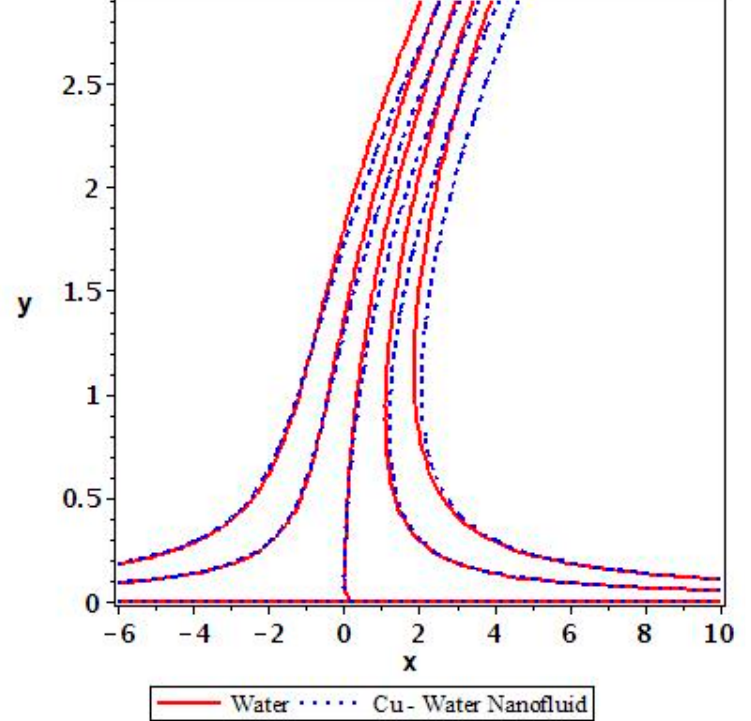
Figure 10. Streamlines for 𝛟 = 𝟎 and 𝛟 = 𝟎.𝟏 with 𝛄 = 𝟏 .